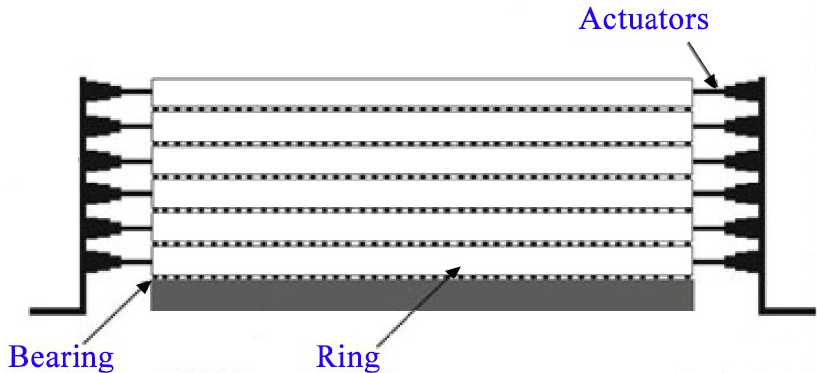
Figure 6. Active boundaries container (From [29]; modified).